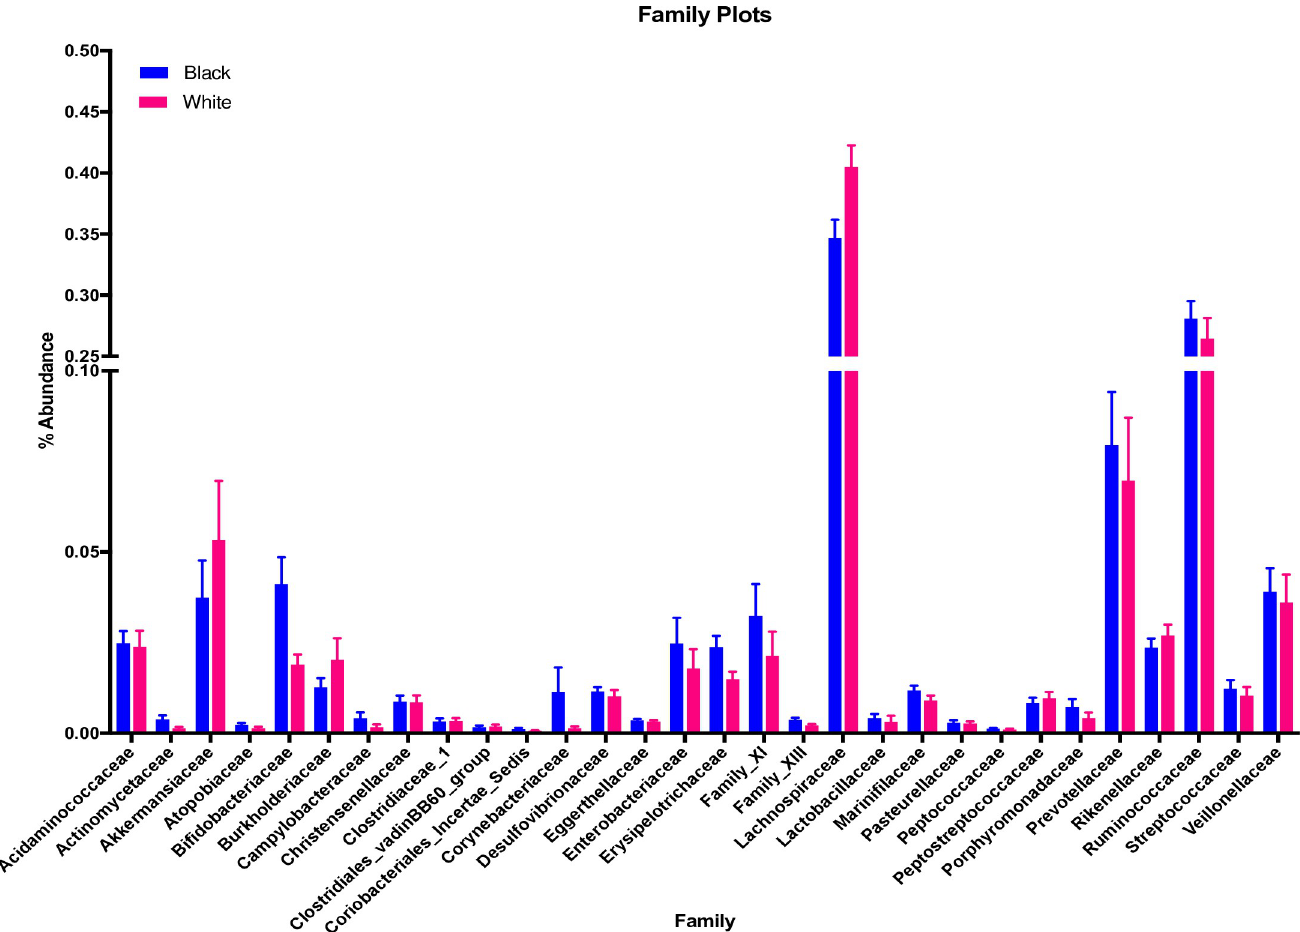
Fig 3. Family abundance by race. Bar graph of the % abundance of 30 identified bacterial families in 168 Black (n = 94) and White (n = 74) women.